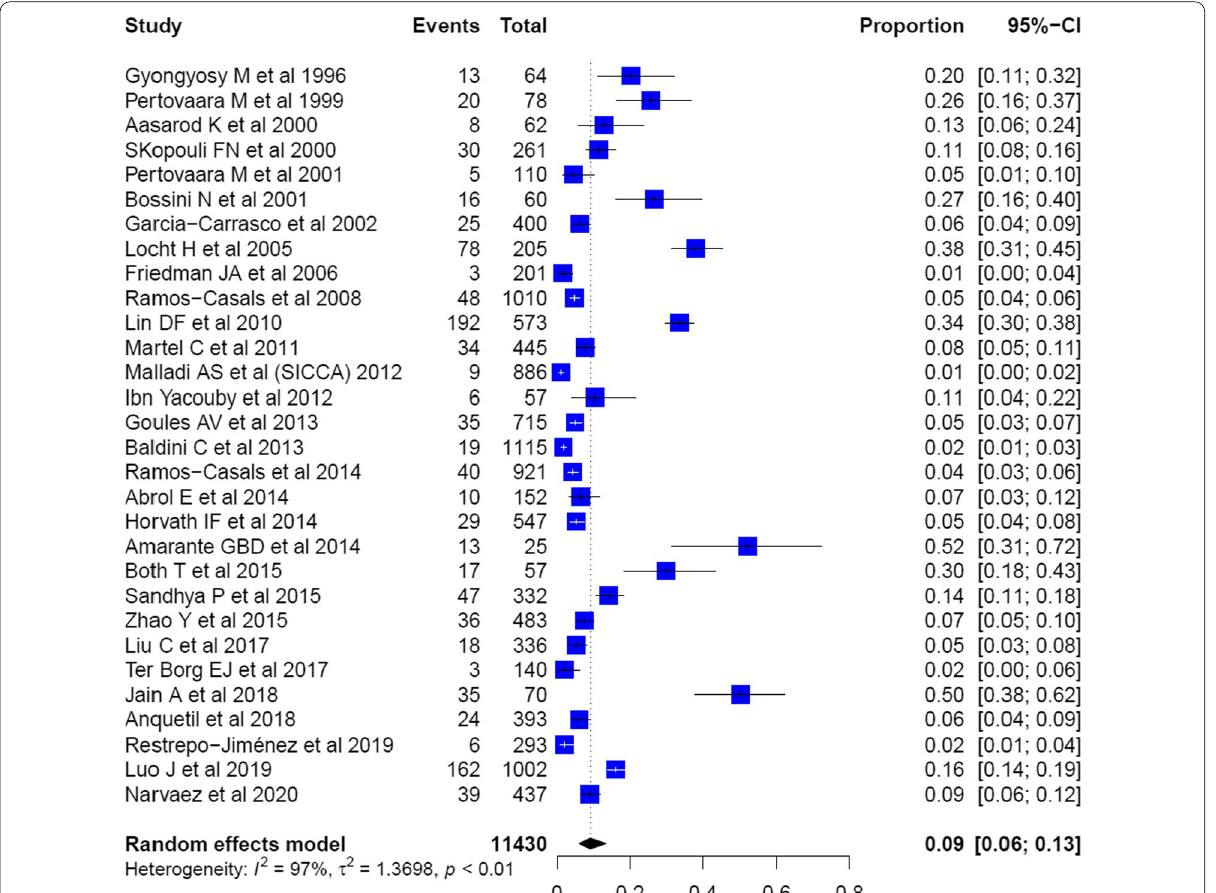
Fig. 12 Meta‑analysis of the Renal Manifestations in pSS in patients with Sjogren’s